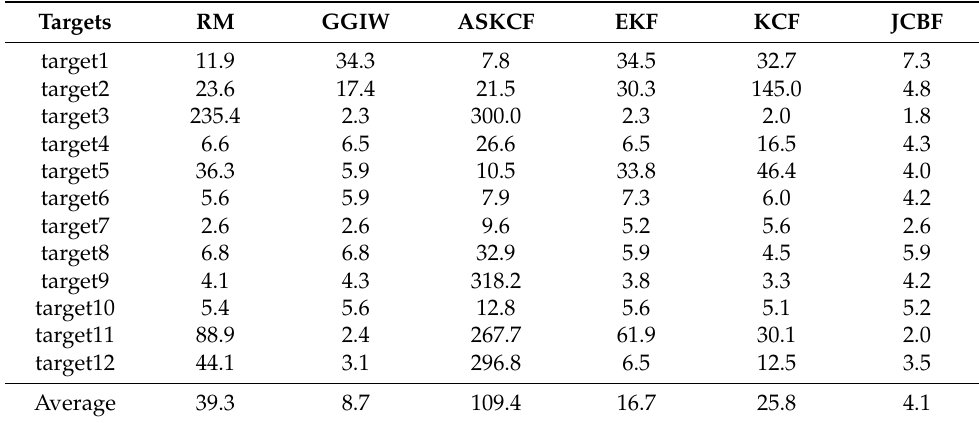
Table 5. Center location error (CLE ↓ , ↓ means lower is better).